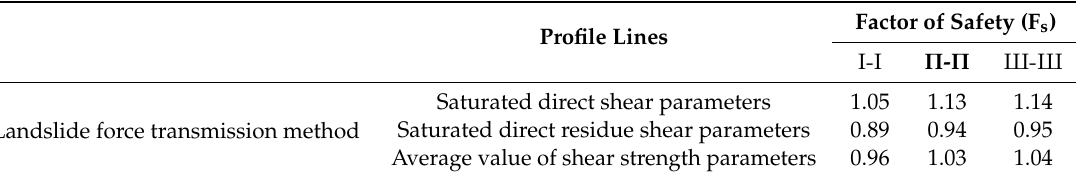
Table 4. Landslide force transmission method for calculating the safety